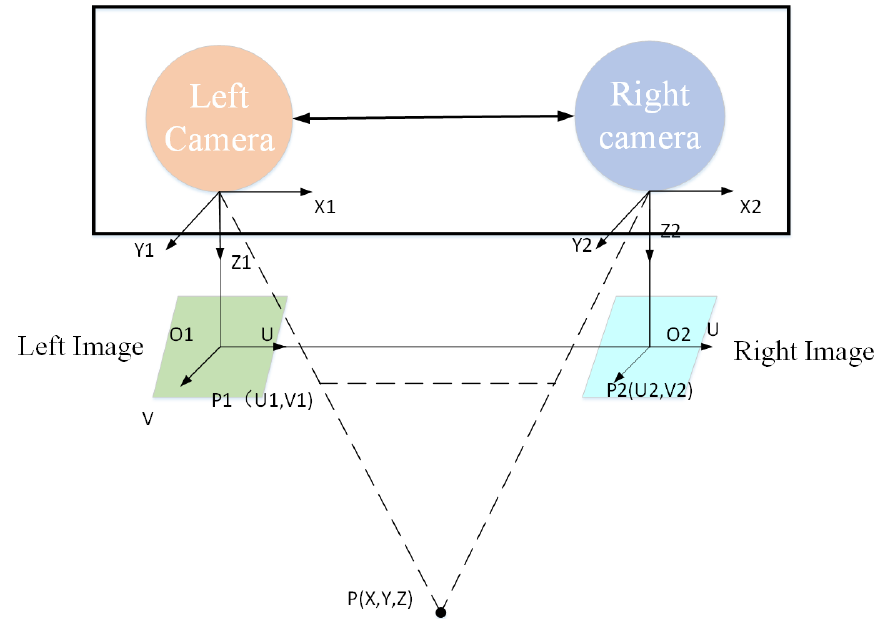
Figure 10. Stereo matching principle based on binocular